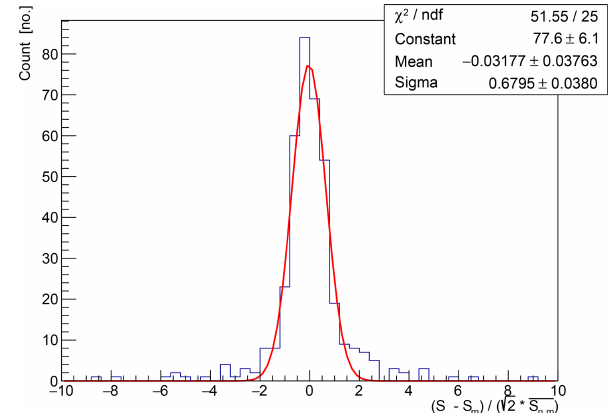
Figure 9. Histogram of the relative variations between repeated measurements of the same hole pairs for all frequencies.